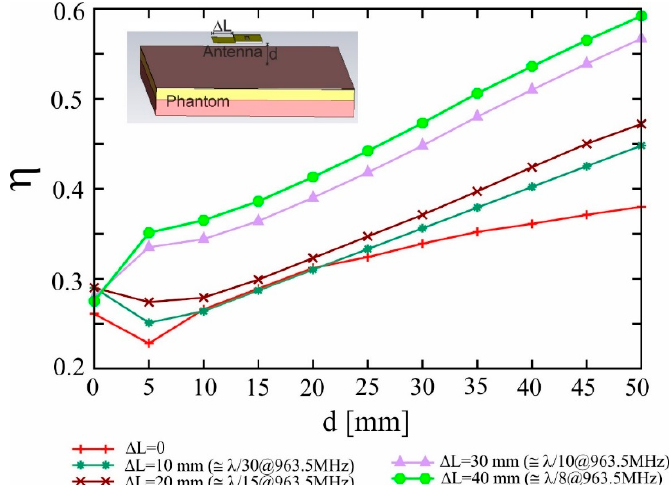
Figure 5. η with respect to the distance from the body phantom for different extensions of the antenna ground plane.